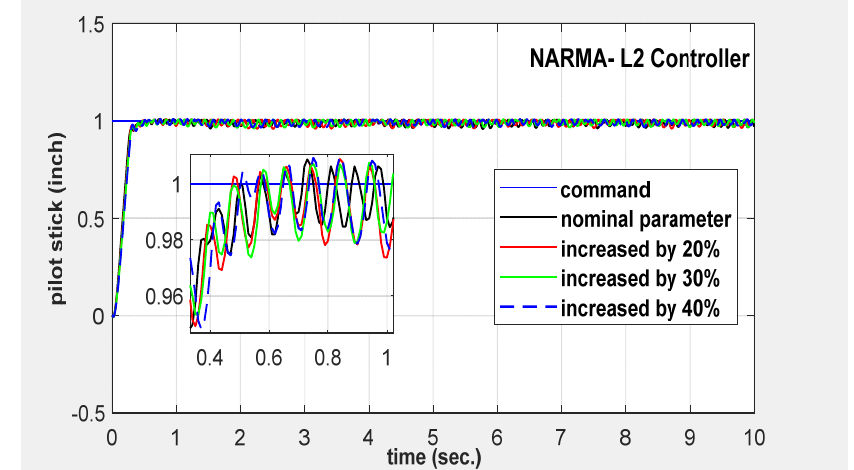
Figure 23. System response basedNARMA-L2 with parameters perturbation.